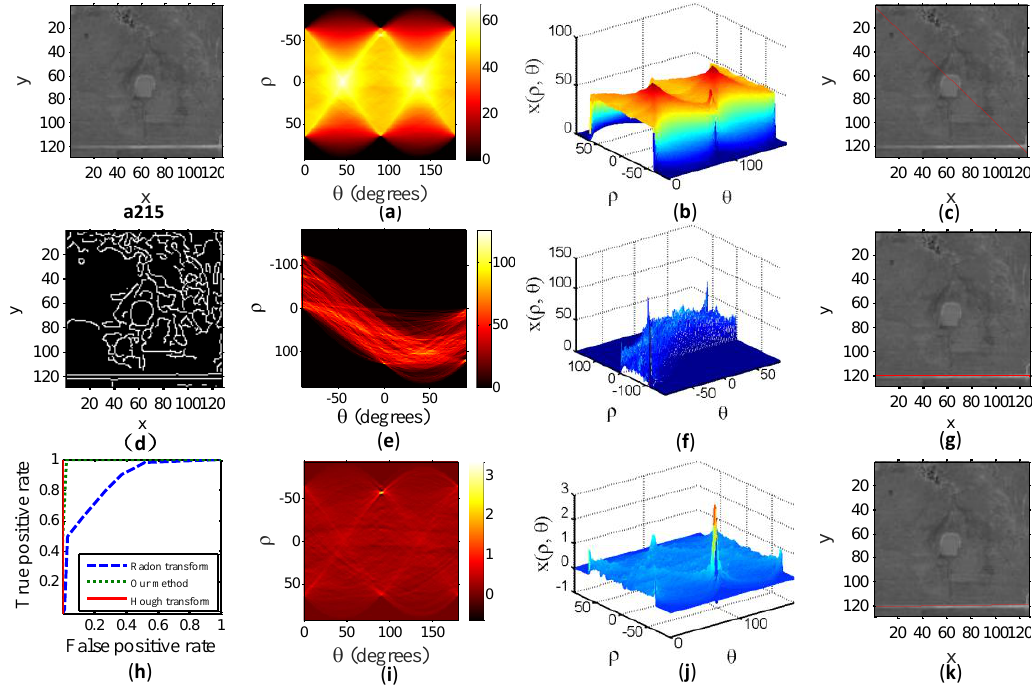
Figure 4. a215 is a test image. ( a ) Radon transform of test image in two-dimensional parameter space. ( b ) Three-dimensional form of ( a ). ( c ) Detected line from ( b ) overlaid on test image. ( d ) Binary image of the test image. ( e ) Hough transform of ( d ). ( f ) Three-dimensional form of ( e ). ( g ) Detected line from ( f ). ( h ) Receiver Operator Curves of the evaluated detection methods. ( i ) Transform image obtained by our method. ( j ) Three-dimensional form of ( i ). ( k ) Detected line from ( j